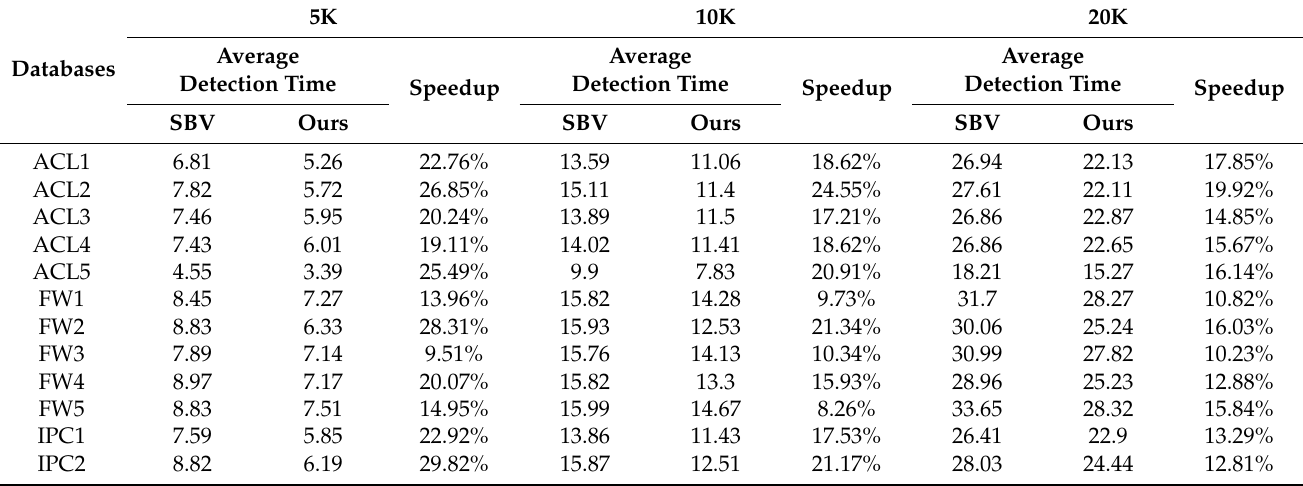
Table 13. Average detection time required to detect conflicts for databases of three